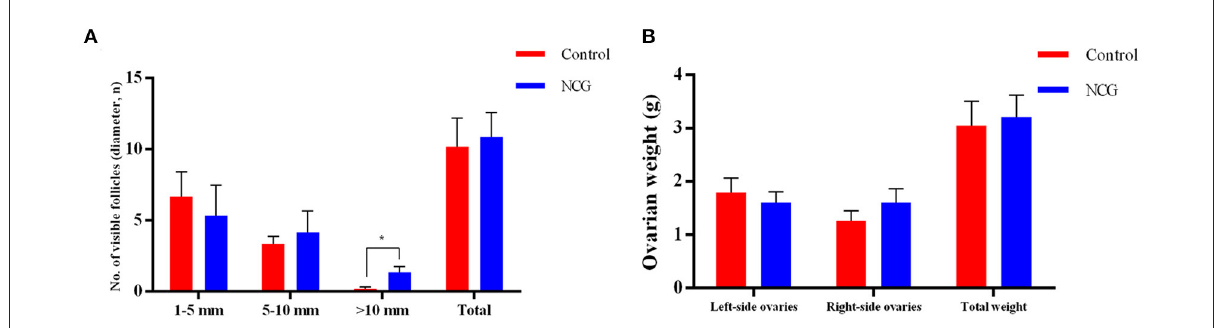
FIGURE1 Average number of follicles of different sizes (A) and ovarian weight (B) for the two treatment conditions. All data are presented as mean and standard error. * P < 0.05.